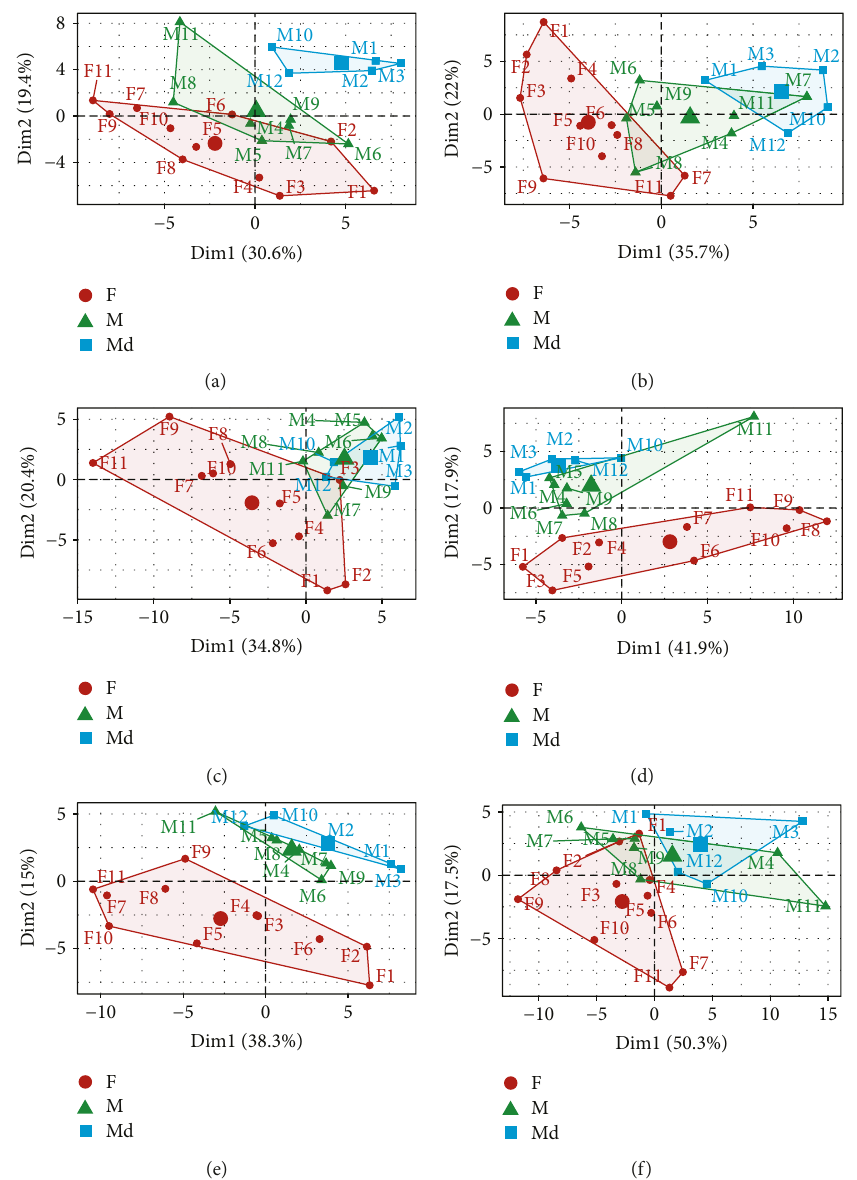
Figure 3: PCA to characterize plasma- and tissue-speci fi c metabolite pro fi les in 12 male and 11 female NZO mice. (a) Plasma; (b) adipose tissue; (c) liver; (d) muscle; (e) heart; (f) kidney. PCAs comprise data of 43 ACs and 35 AAs. Groups are coloured according to female (F), male (M), and male diabetic (Md) mice to examine di ff erences and resemblances among plasma and tissue metabolite pro fi les. Gender is marked with F (female) and M